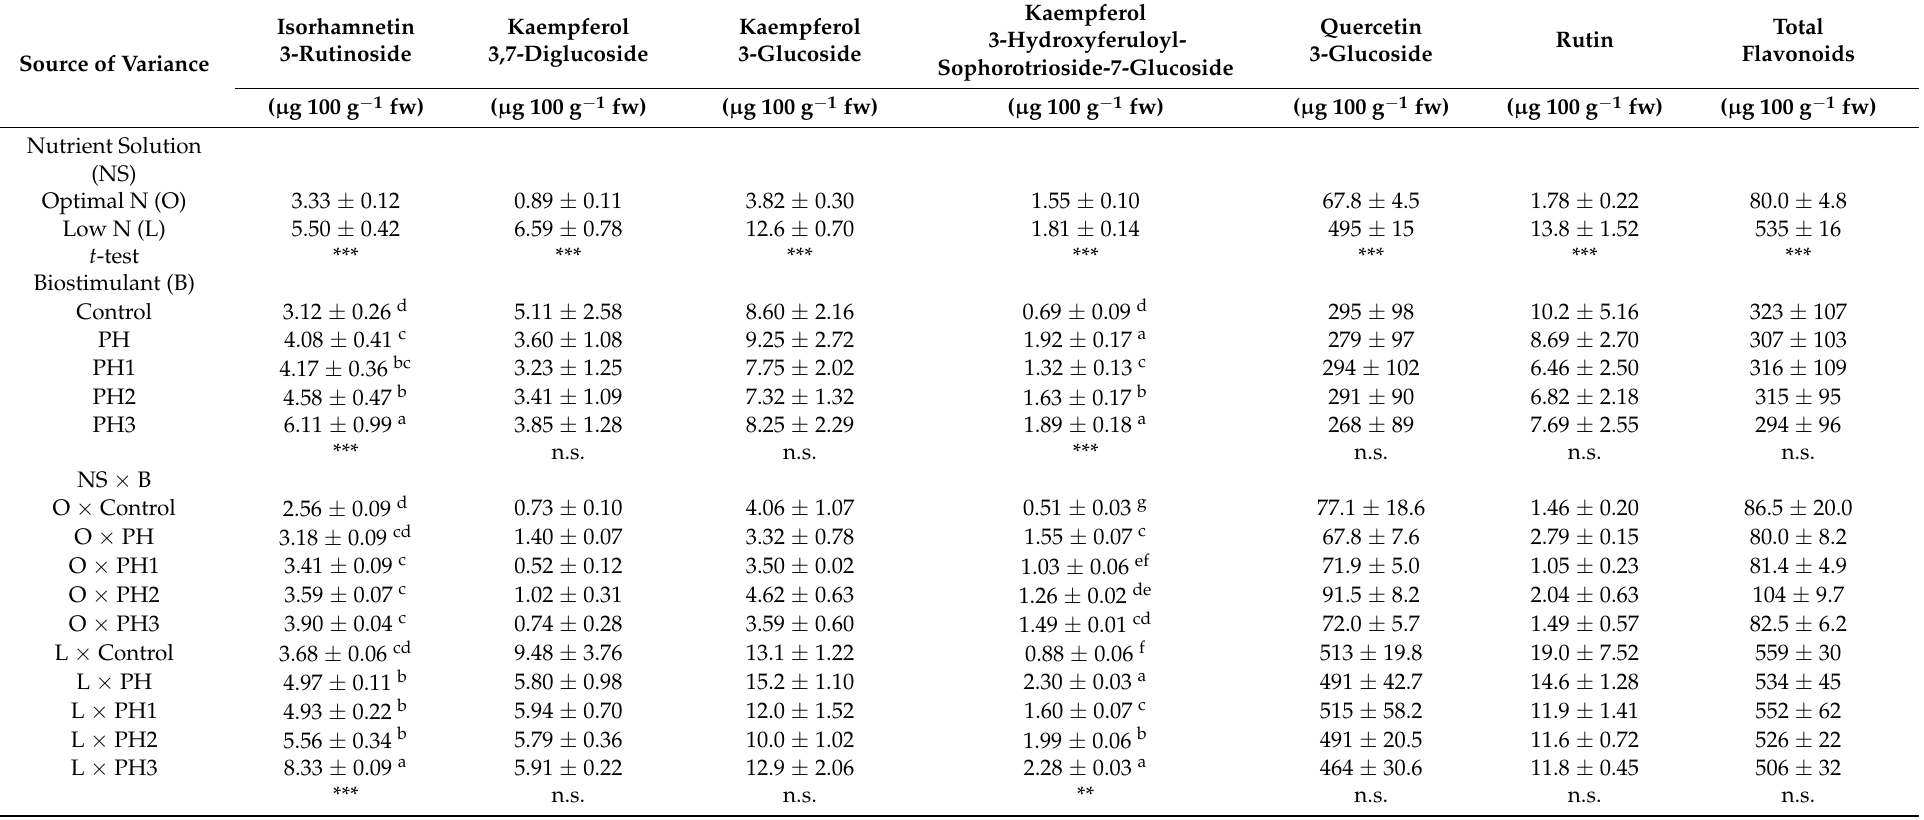
Table 4. Flavonoids profile of lettuce plants as affected by nitrogen dosage and biostimulant